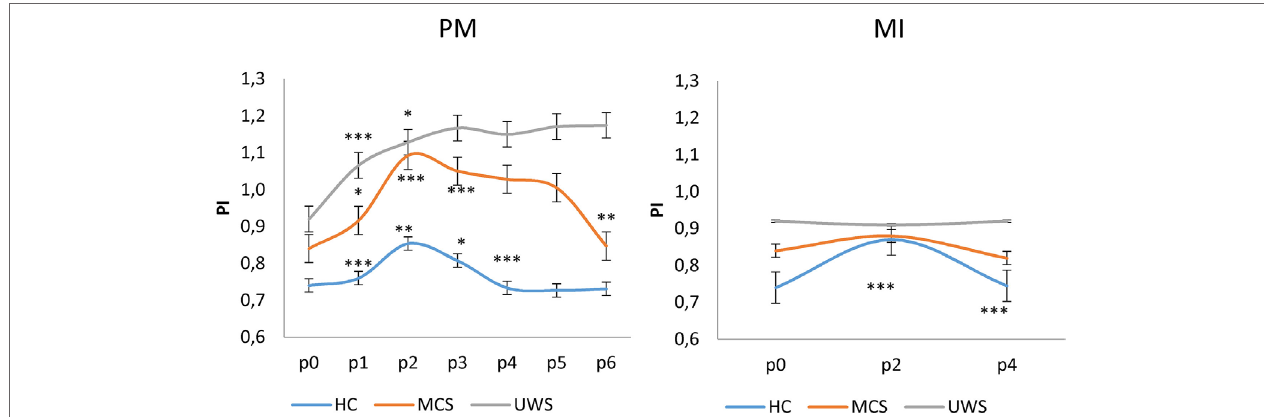
FigUre 2 | Shows mean ( ± SD; vertical error bar) pulsatility index (PI) values during passive movement (PM) and motor imagery (MI) tasks for each group [healthy controls (HC), minimally conscious state (MCS), and unresponsive wakefulness syndrome (UWS)] across the hand positions (p) explored. There was a significant difference at p0 (baseline) between the PI values of HCs and patients with disorders of consciousness ( p < 0.001), and between patients with MCS and UWS ( p = 0.01). PM induced a significantly different PI modulation at each p among the groups ( p < 0.001). On the contrary, MI induced a significant increase of PI at p2 and decrease at p4 only in the HCs. *Refer to the significance of intragroup PI change at each p as compared to the previous one (Bonferroni corrected p -value, *** p < 0.001, ** p = 0.001, * p <